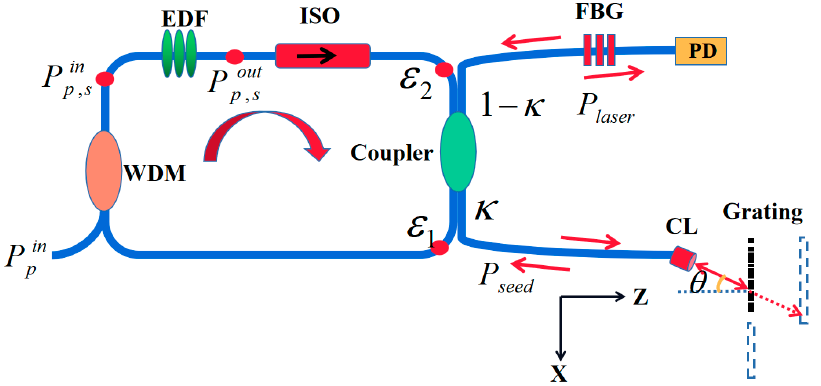
Figure 1. Schematic diagram of an all-fiber LFI with a reflection grating. WDM, wavelength division multiplexer; EDF, erbium-doped fiber; ISO, fiber optic isolator; FBG, fiber Bragg grating; PD, photodetector; CL, collimator lens.